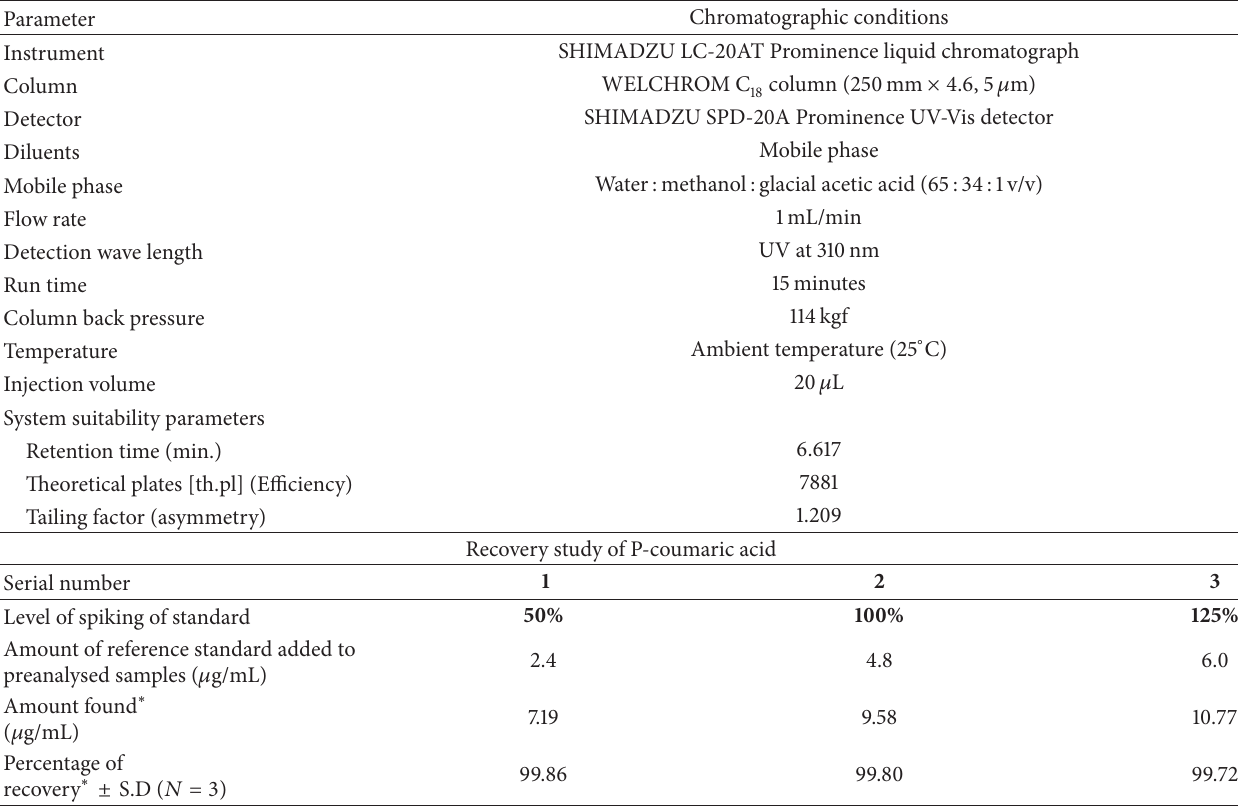
Table 3: Optimised chromatographic conditions, system suitability, and recovery study.